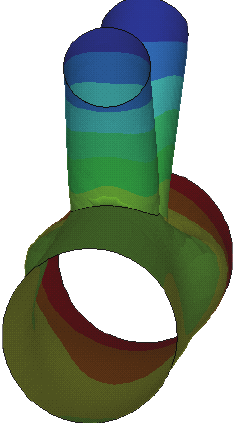
Figure 9: Plane deformation of branch